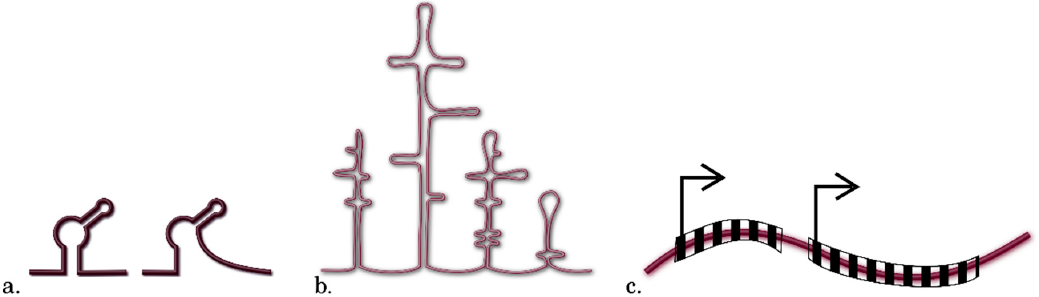
Figure 6. Examples of some mRNA cis-regulatory elements: ( a ) riboswitches; ( b ) internal ribosome entry sites (IRESs); and ( c ) alternative open reading frames.